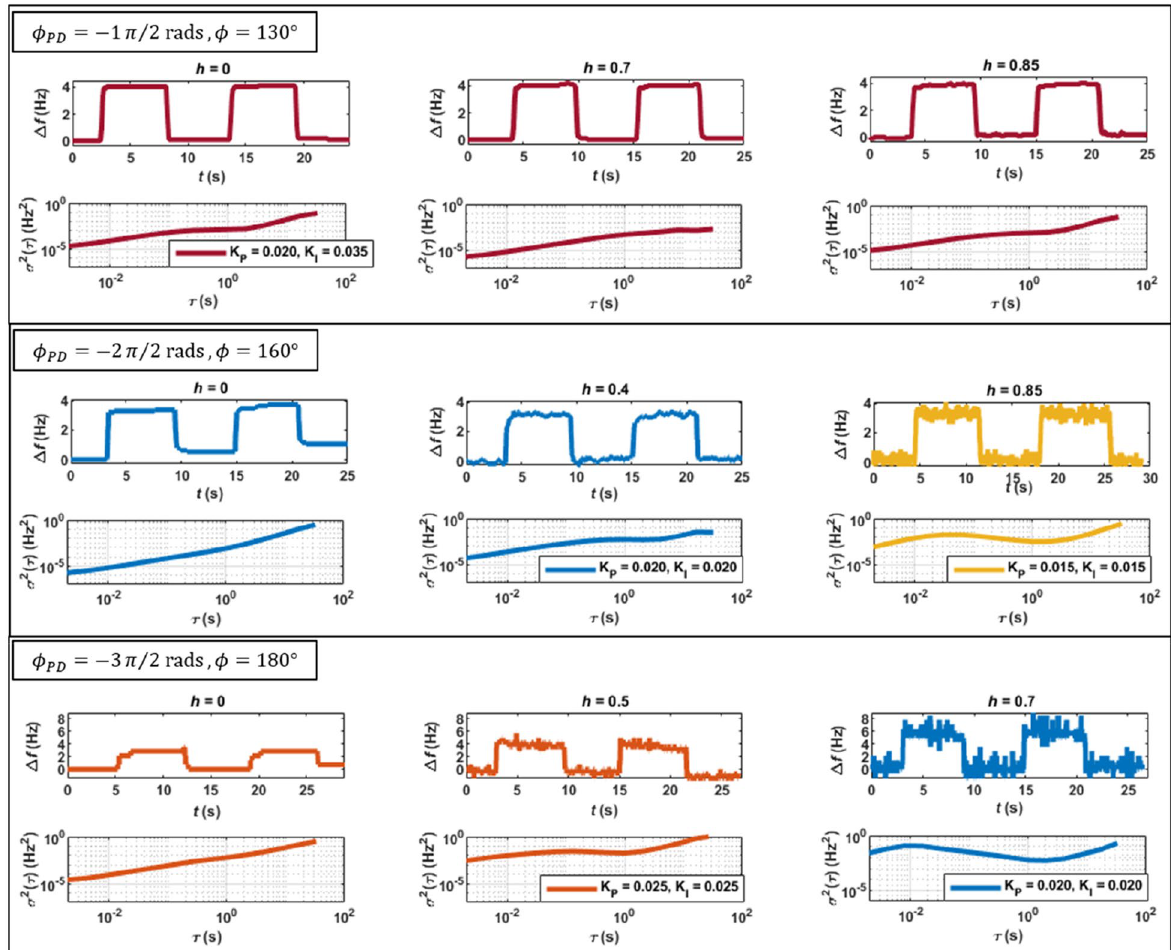
Figure 3. Real-time shifts of frequency caused by pressure cycles (7 mbar) in the closed cell and Allan variation of the resonator, as function of the parametric pump gain h and phase φ PD , for fixed imposed phases φ in the PLL. Each pair of controller conditions ( K P and K I ) is represented by a different